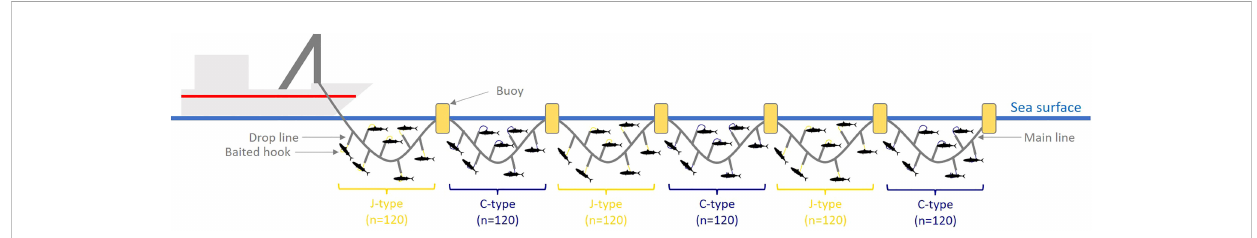
FIGURE 2 Scheme of the functioning of the pelagic longline used in the study and the position of the J-type hooks and C-type hooks along the pelagic